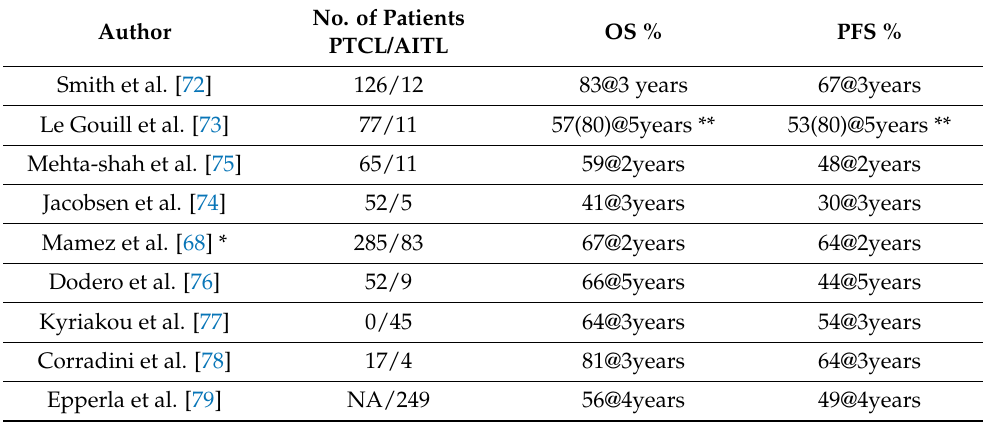
Table 3. Outcomes of Allogeneic stem cell transplantation in